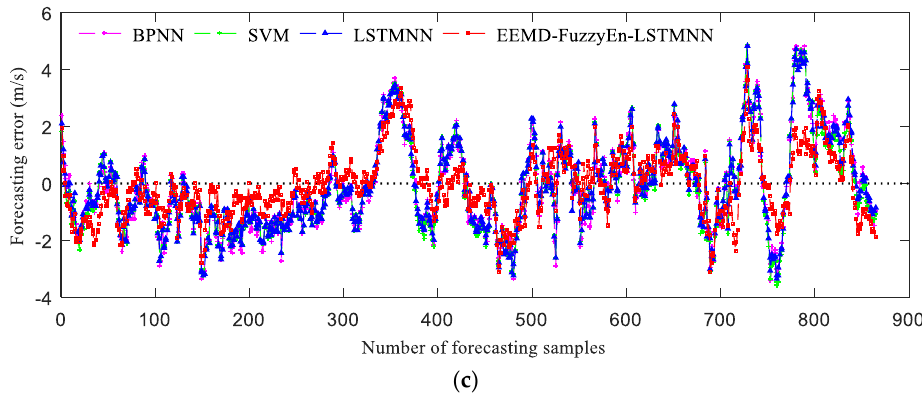
Figure 9. Forecasting error of wind speed series: ( a ) Case A; ( b ) Case B; ( c ) Case C.